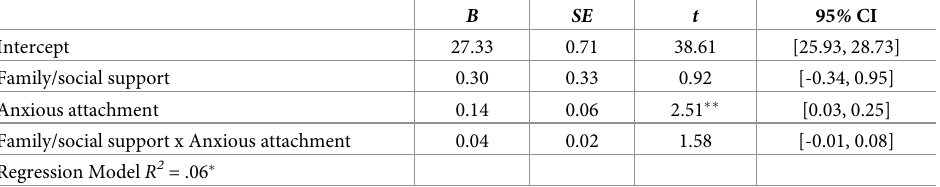
Table 5. Anxious attachment moderates the relationship between family/social support and intensity of pro- longed grief